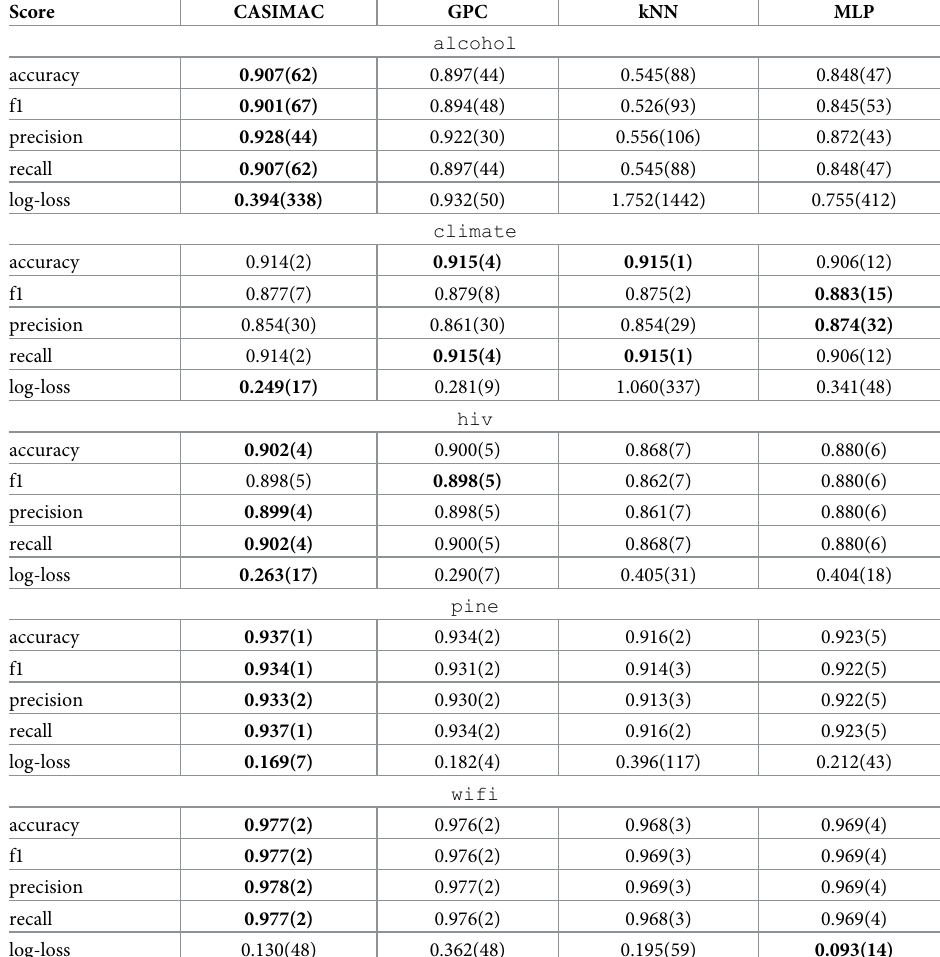
Table 3. Real-world data test scores. Test scores for the benchmarked classifiers on the five real-world data sets from Table 2. We show the means and the corresponding standard deviations (in brackets) over all 10 classification tasks. The best mean results are highlighted in